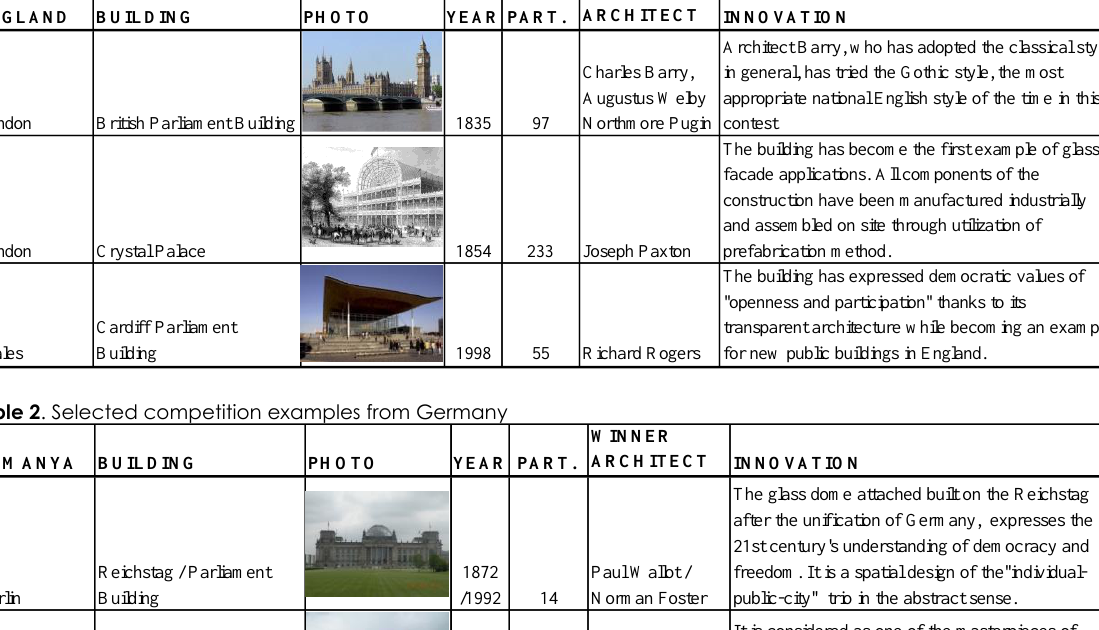
Table 1 . Selected competition examples from the U.K